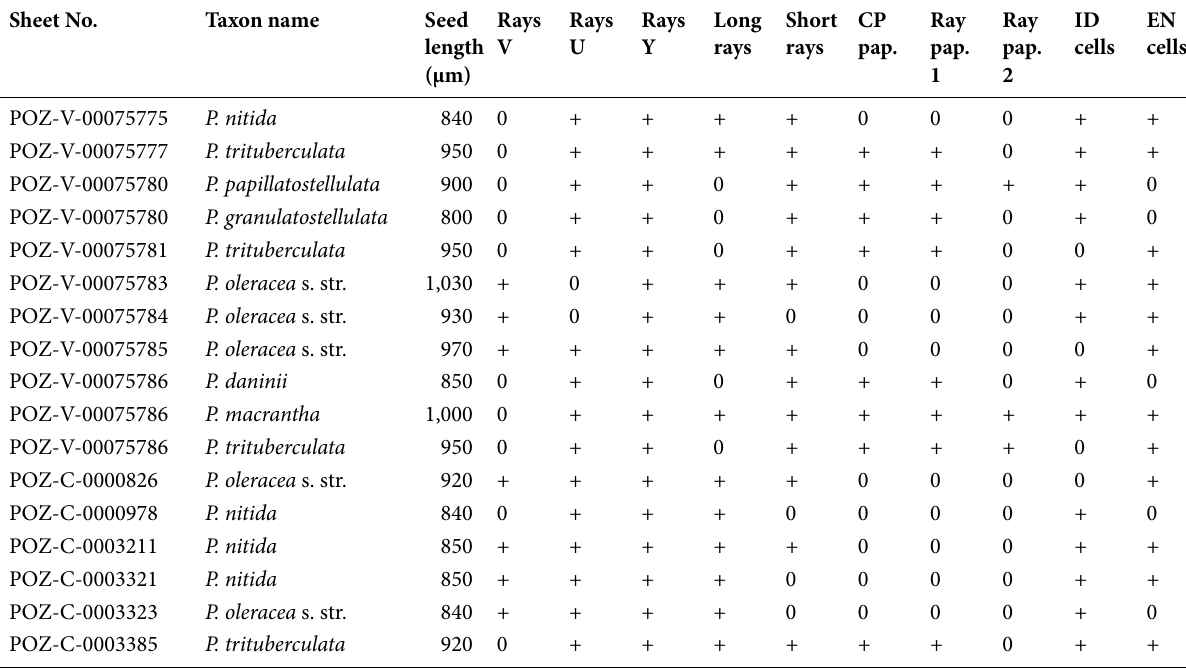
Table 2 Identified taxa of Portulaca oleracea aggr. deposited in the POZ Herbarium. Sheet